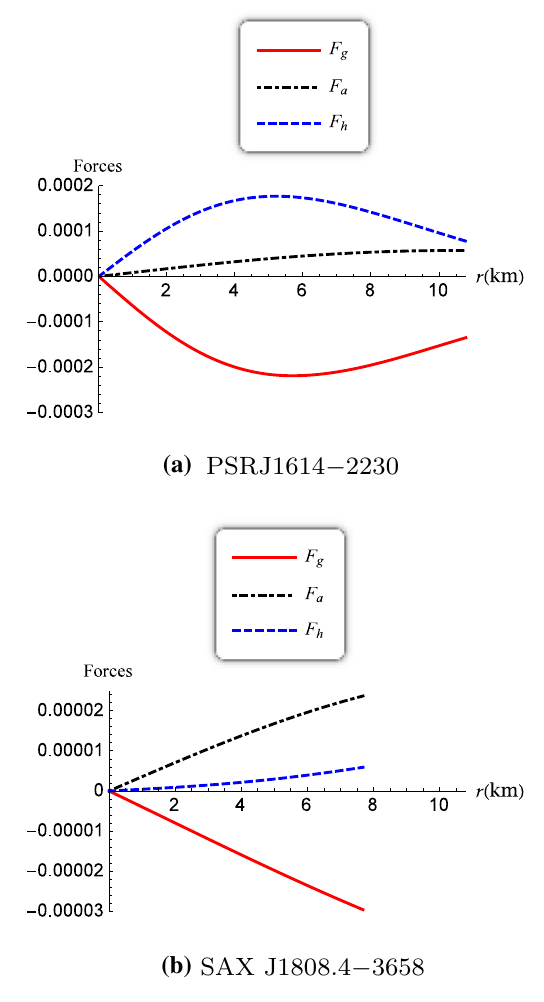
Fig. 11 Variation of the forces verses the radius stability criteria are satisfied. In Fig. 12 we have plotted the variation of the mass versus radius for stellar objects PSR J1614-2230 and SAX J1808.4-3658. In both cases the mass function is a increasing quantity with increasing radius.